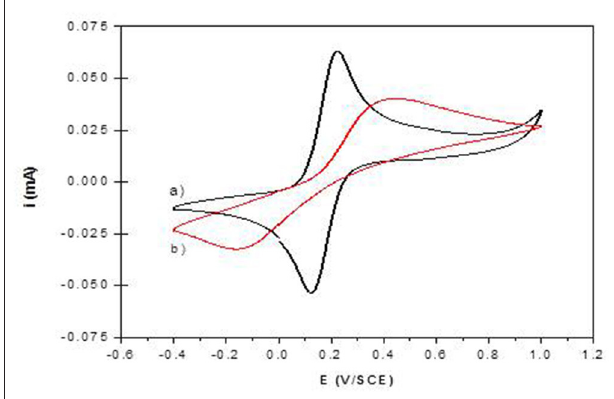
FIGURE 8 | Schematic representation of the NiAl@Alg-Ca/ITO and NiAl-Alg/ITO.